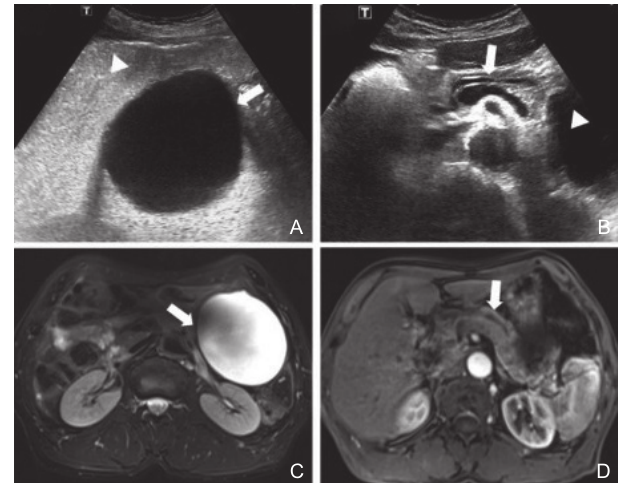
C D Figure 3 A 65-year-old male patient with low/moderate-grade dysplasia Figure 2 A 71-year-old male patient with low/moderate-grade dysplasia pancreatic IPMN. Transabdominal ultrasound displayed a cystic lesion pancreatic IPMN. Ultrasound displayed a lesion (arrow) in the pancreatic in the pancreatic tail (arrow) with the stomach full of hyperechoic head with a hyperechoic mural nodule (triangle arrow) (A) and the gastrointestinal contrast agent (triangle arrow) (A); a mildly dilated lesion communicated with the main pancreatic duct (triangle arrow) (B). pancreatic duct (arrow), and a cystic lesion (triangle) (B); magnetic Computed tomography (C) and magnetic resonance (D) showed the cystic resonance imaging showed a cystic lesion (arrows) in the pancreatic tail (C) lesion (arrows). and the dilated pancreatic duct (D). Table 2 Comparison of the quantitative diagnostic efficacy of transabdominal ultrasound, computed tomography, and magnetic resonance imaging Group Cases ( n )